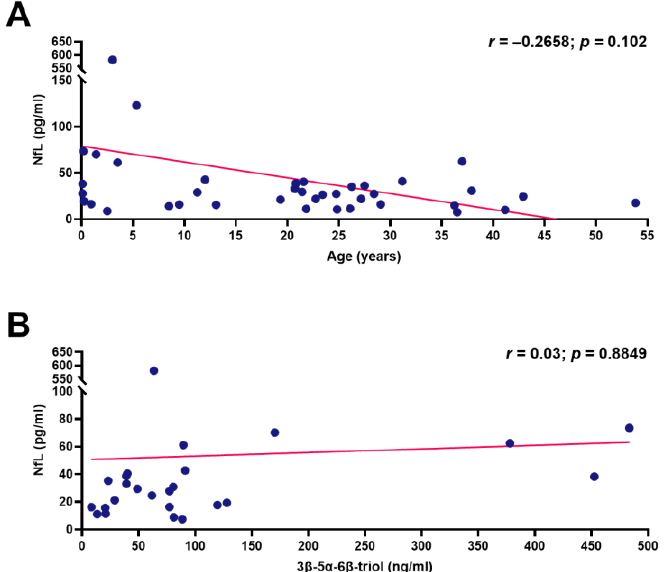
Figure 3. Association of NfL concentrations in the plasma of NPCD patients with age ( A ) and 3 β ,5 α ,6 β -triol ( B ). Correlations were assessed by Pearson’s linear regression correlation test. Plasma levels of cholestan 3 β -5 α -6 β -triol were measured in samples taken during the first visit in 25 out of 26 patients, and no correlation between plasma levels of this oxysterol and those of NfL was found (Pearson’s correlation coefficient = 0.03; p = 0.8849) (Figure